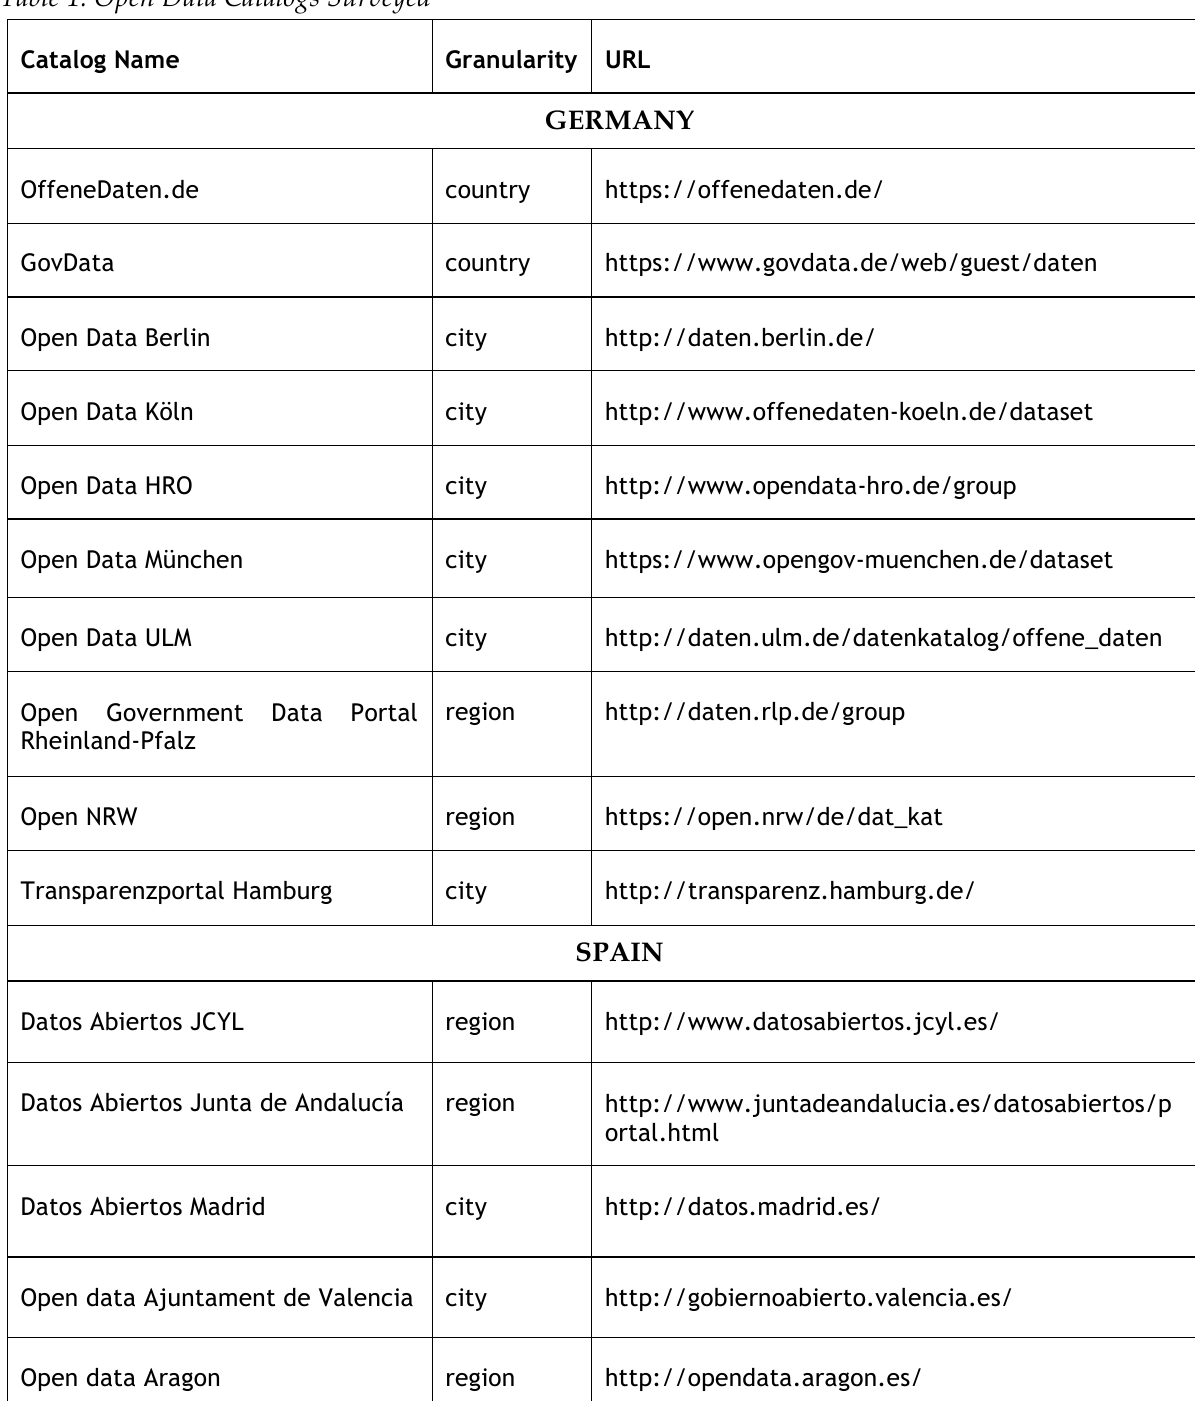
Table 1: Open Data Catalogs Surveyed Catalog